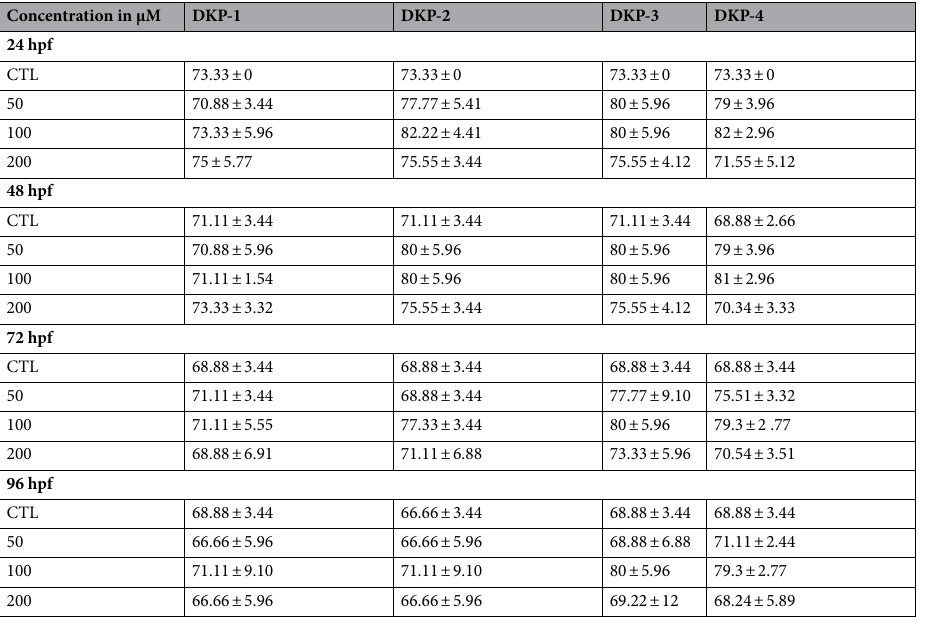
Table 3. Mean survival rates (in three replicates) of DKPs treated and untreated zebrafish embryos. Data are represented as mean ± SD (n = 3). DKP-1: cyclo (l-Pro-l-Leu) ( A ), DKP-2: cyclo (l-Pro-l-Val) ( B ), DKP-3: cyclo (l-Pro-l-Phe) ( C ), and DKP-4: cyclo (l-Pro-l-Tyr) ( D ). hpf – hours post fertilization; CTL